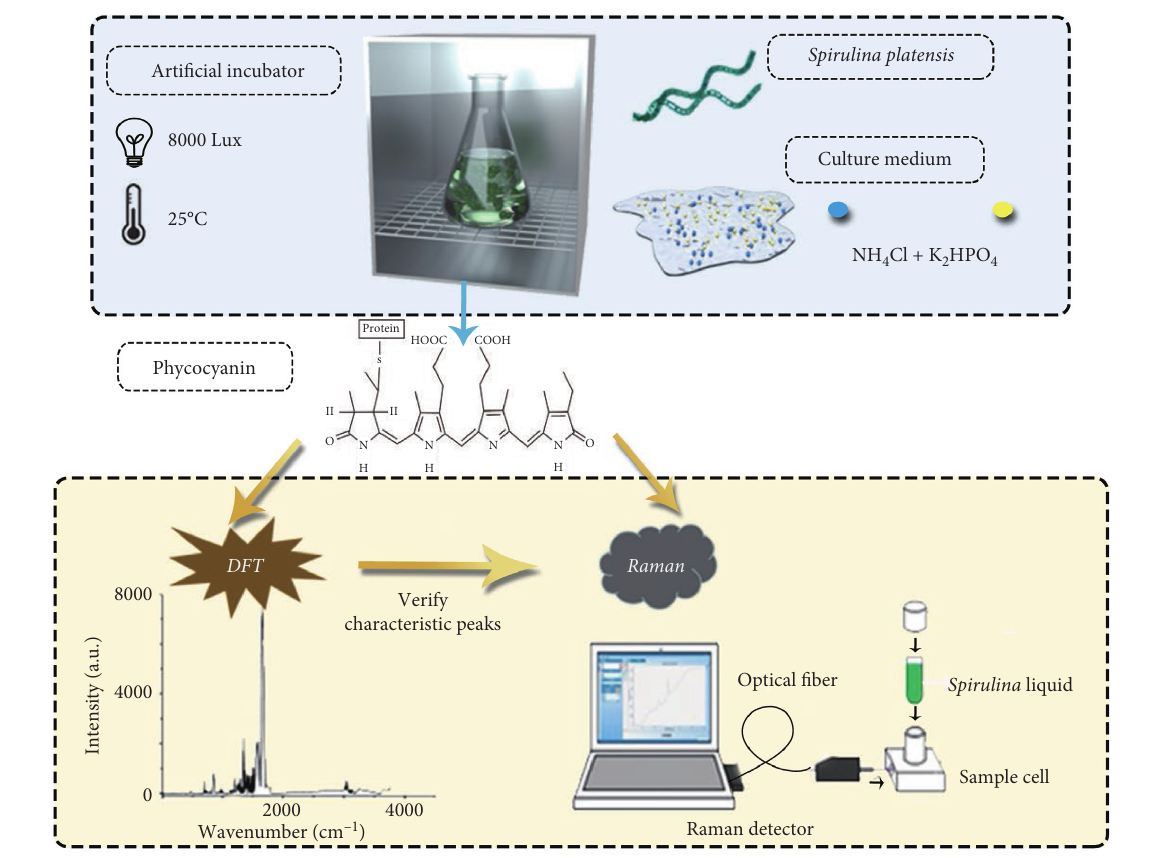
Figure 1: Schematic overview of the analytical procedure. Table 1: Concentration of culture medium components in the experimental